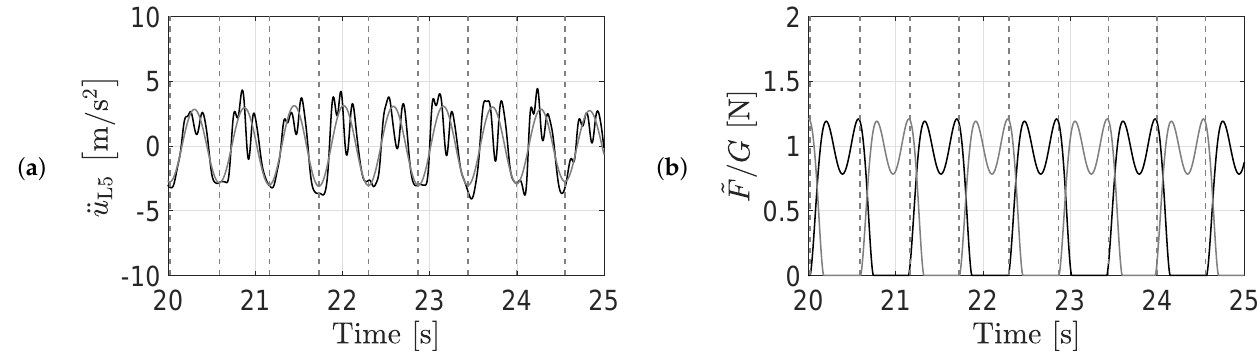
Figure 10. Illustration of the contact force reconstruction method provided in [13]: ( a ) L5 acceleration (black solid line) and fundamental main harmonic component (gray solid line) with indication of the consecutive footfalls corresponding to the local minima of the fundamental main harmonic (gray dashed lines), ( b ) step-by-step contact force reconstruction using Butz’s single-step force model for one foot (black) and the other foot